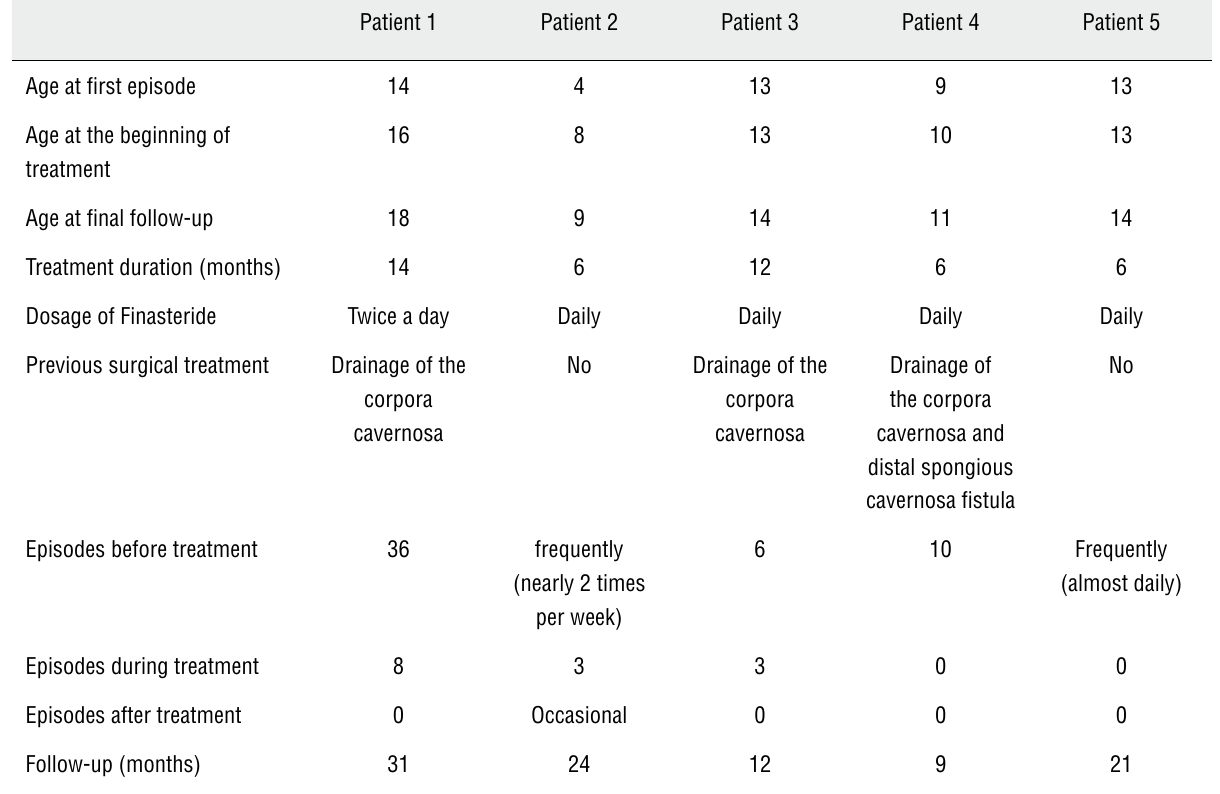
Table 1 - details of the